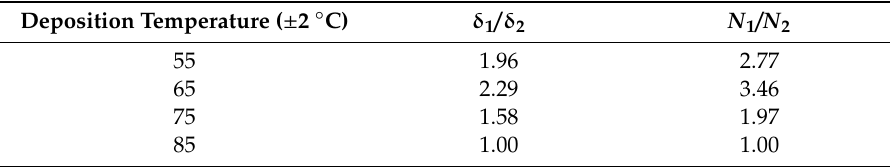
Table 2. Comparative analysis of the dislocation density and number of crystallites per unit area of the CdTe films electroplated at di ff erent temperature under AD and CCT conditions.